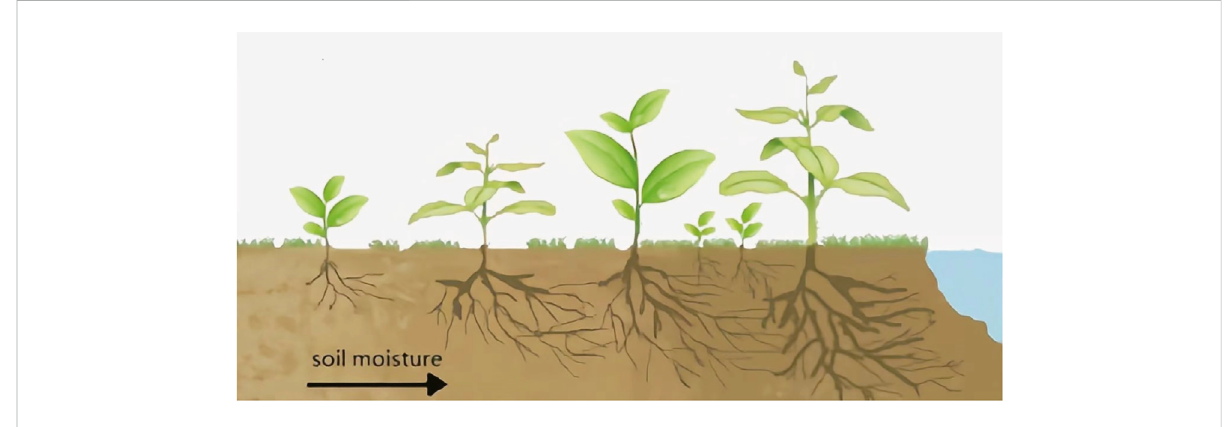
FIGURE 1 Schematic chart of hydrotropism of vegetation roots and the arrow direction indicates that the soil moisture is getting higher and higher. The roots of vegetation grow in areas to obtain more water resources.